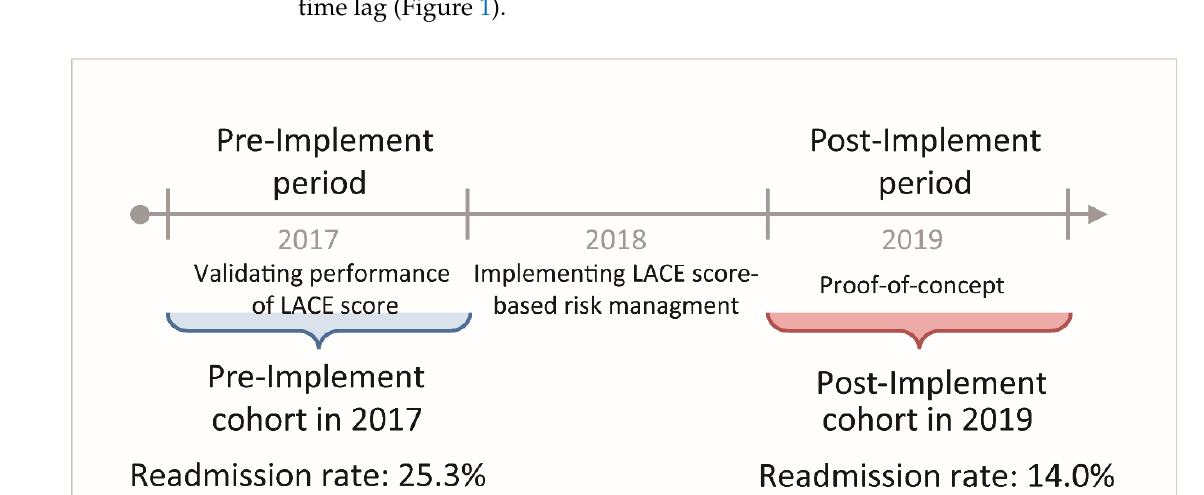
Figure 1. Definition of study cohorts before and after implementing LACE score-based predictive risk management tool in the medical center affiliated home care unit in Taiwan, 2017 and 2019.